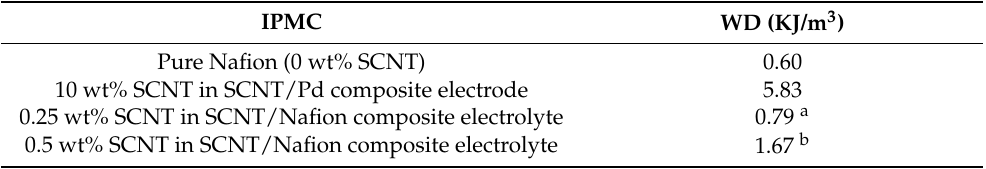
Table 1. Volume work density values of IPMCs with SCNTs in SCNT/Pd composite electrode and SCNT/Nafion composite